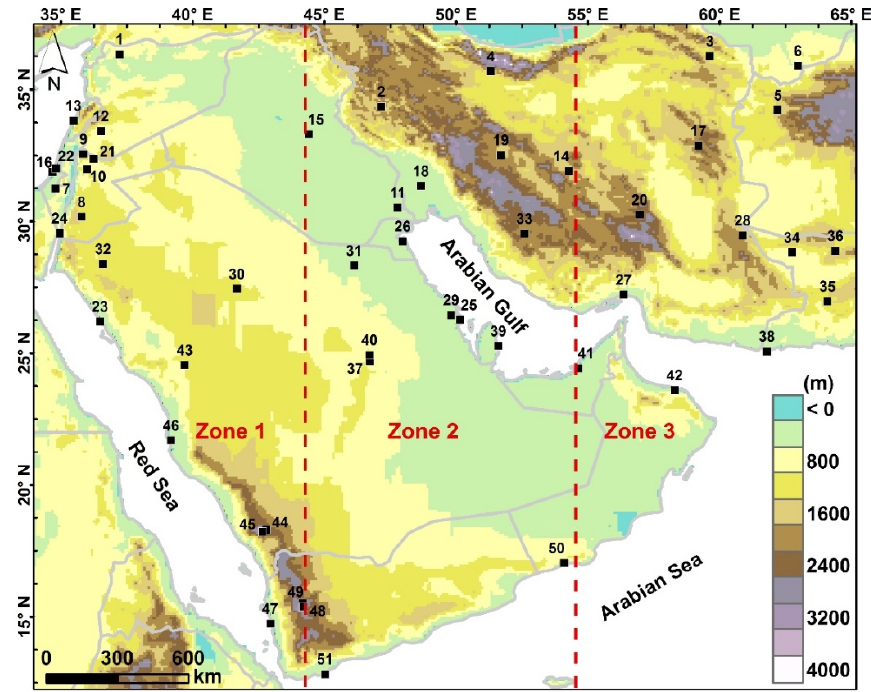
Figure 1. A map showing the study area along with locations of Integrated Global Radiosonde Archive (IGRA) radiosonde sites used and elevation. Refer to Table S1 for key characteristics.